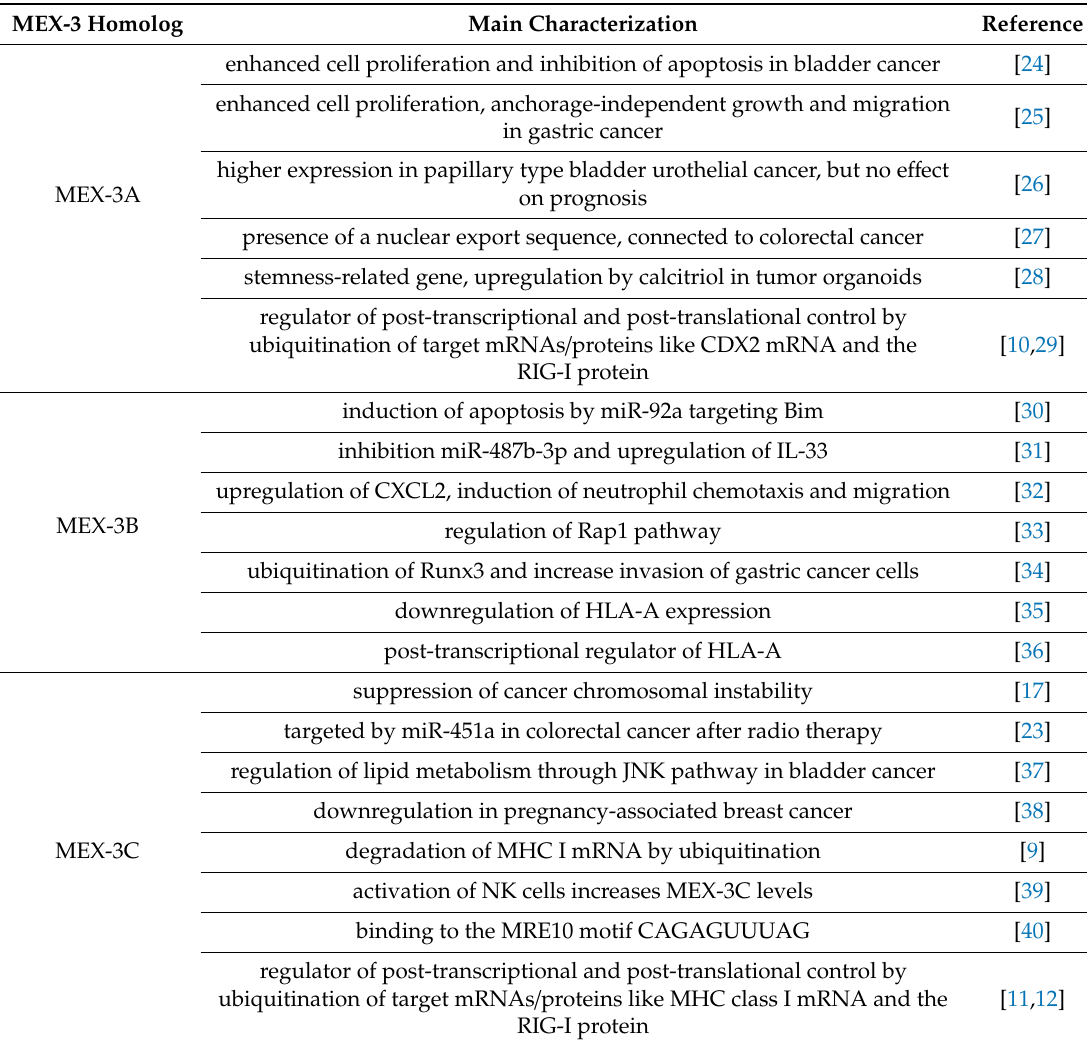
Table 1. Main molecular and cellular characteristics of the MEX-3 homologs in the context of cancer. MEX-3